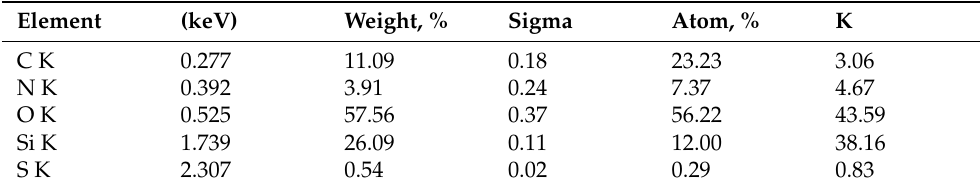
Figure 4. SEM micrograph and distribution of sulfur and nitrogen on the surface of the SA catalyst. Table 2. Distribution of elements on the SA surface according to EDA data.